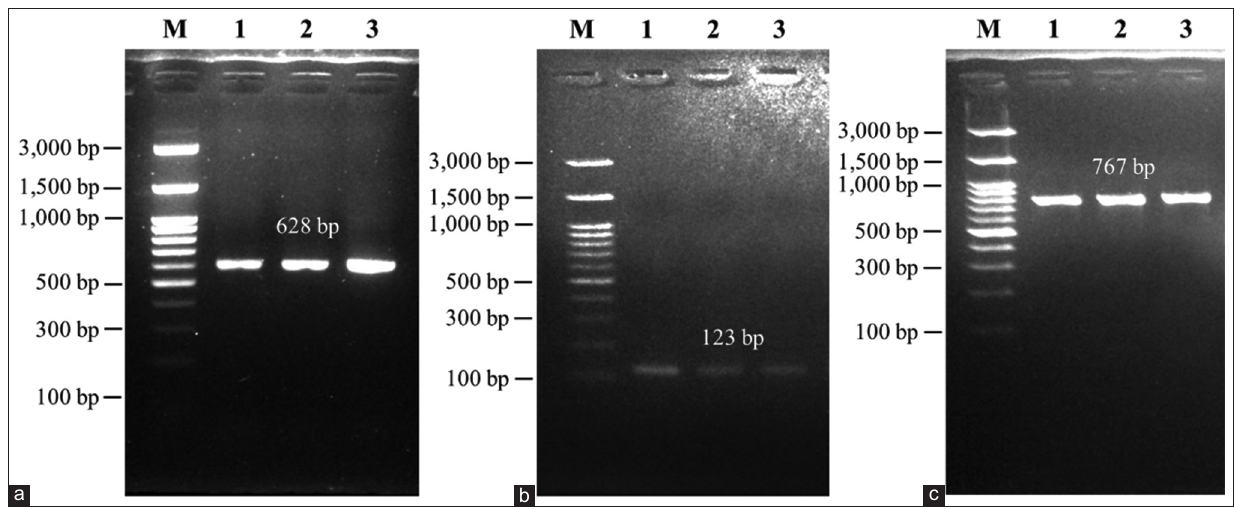
ba Figure-2: Amplification of pleomorphic adenoma gene 1 polymorphisms. (a) Is an amplicon for detecting the g.48308 C>T single-nucleotide polymorphism (SNP), (b) for detecting the 19 bp indel, and (c) for detecting the g.45233 T>C SNP.